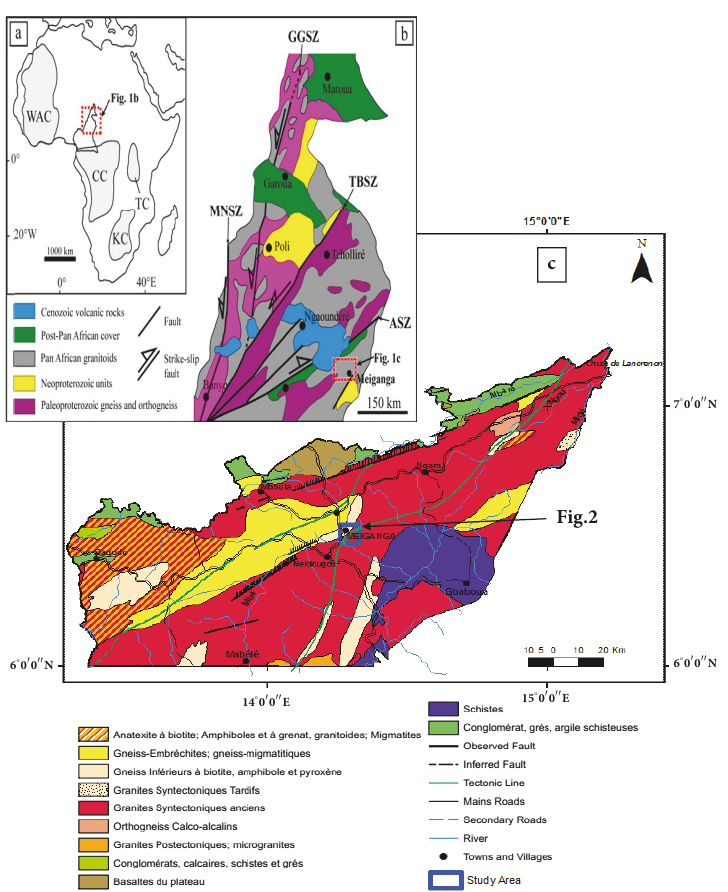
Figure 2: (a) Location of Cameroon in Africa, WAC: West African Craton; CC: Congo Craton; TC: Tanzanian Craton; KC: Kalahari Craton. (b) Geological sketch map of northern part of Cameroon showing from the major lithotectonic domains ([9, 14]; Baise, 1995); MNZ: Mayo Noltishearzone;TBSZ:Tcholir´e-Banyoshearzone;ASZ:Adamouashearzone.(c)GeologicalmapoftheMb´er´edepartment,redrawn(source: Department of Mines and Geology,